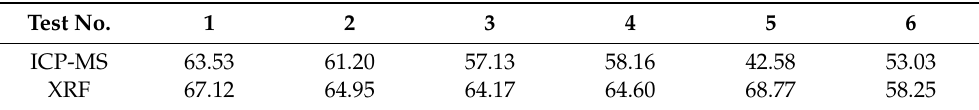
Table 6 . Al percentage extraction determined by ICP-MS analysis of solution samples and material balance via XRF analysis .